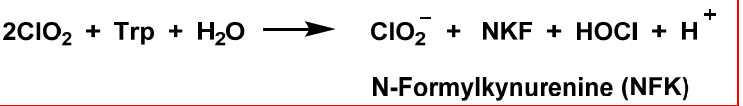
Figure 40. Stoichiometry of the reaction between tryptophan and ClO 2 .